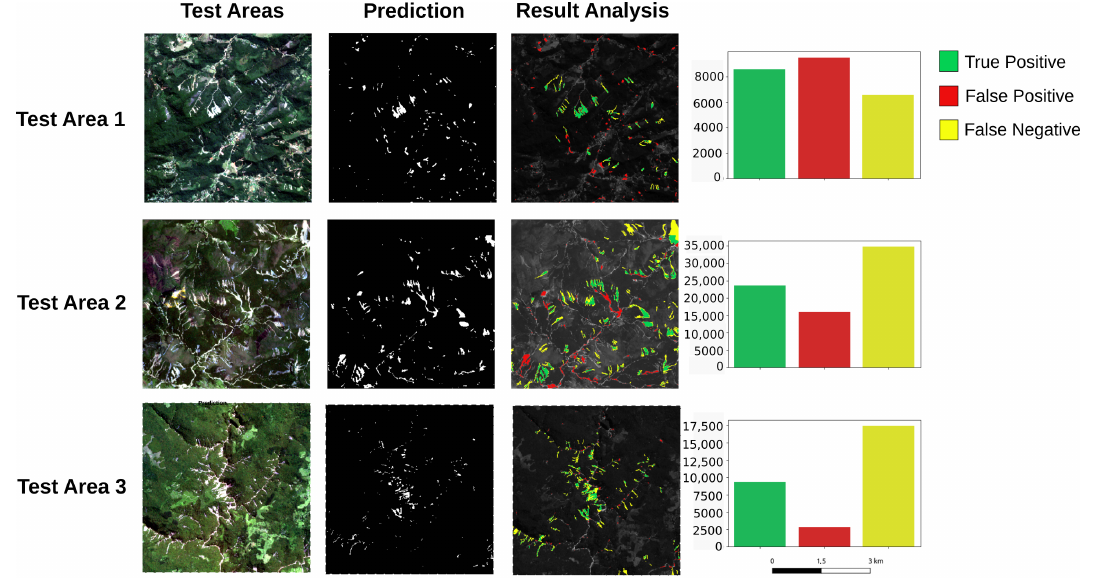
Figure 7. Segmentation results of each test area and result histograms showing the number of pixels representing true positives, false positives, and true negatives. These results correspond to the prediction of the model trained with 128 × 128 pixel tiles and dataset 3 for TA1; the model trained with 32 × 32 tile pixels and dataset 1 for TA2, and the model trained with 64 × 64 pixels and dataset 1